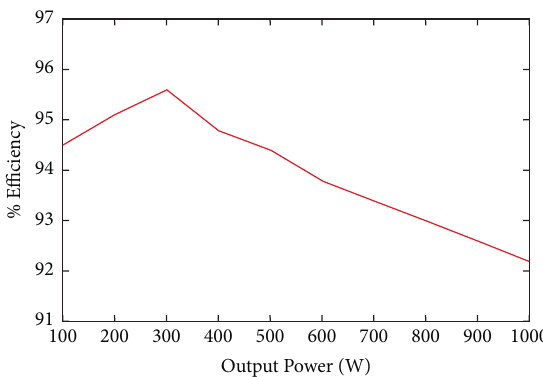
Figure 25: The curve between % efficiency and output power during boost